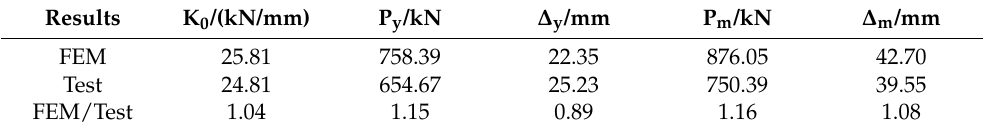
Table 3. Characteristic parameters of specimens.